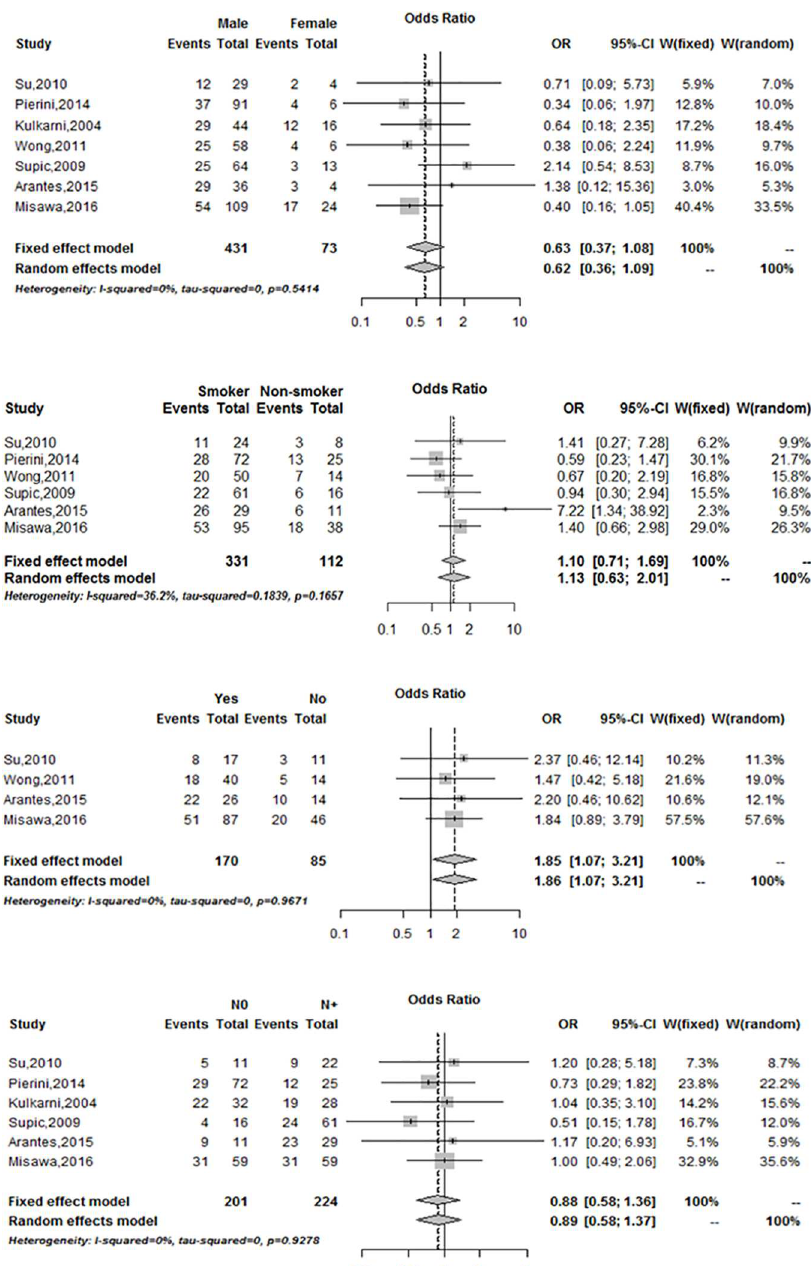
Fig 3. Forest plots of DAPK promoter methylation associatedwith clinicopathological features A: Forest plots of DAPK promoter methylationassociated with sex B: Forest plots of DAPK promoter methylation associated with smoking status C: Forest plots of DAPK promoter methylation associatedwith alcoholstatus D: Forest plots of DAPK promoter methylationassociated with lymph node invasion.